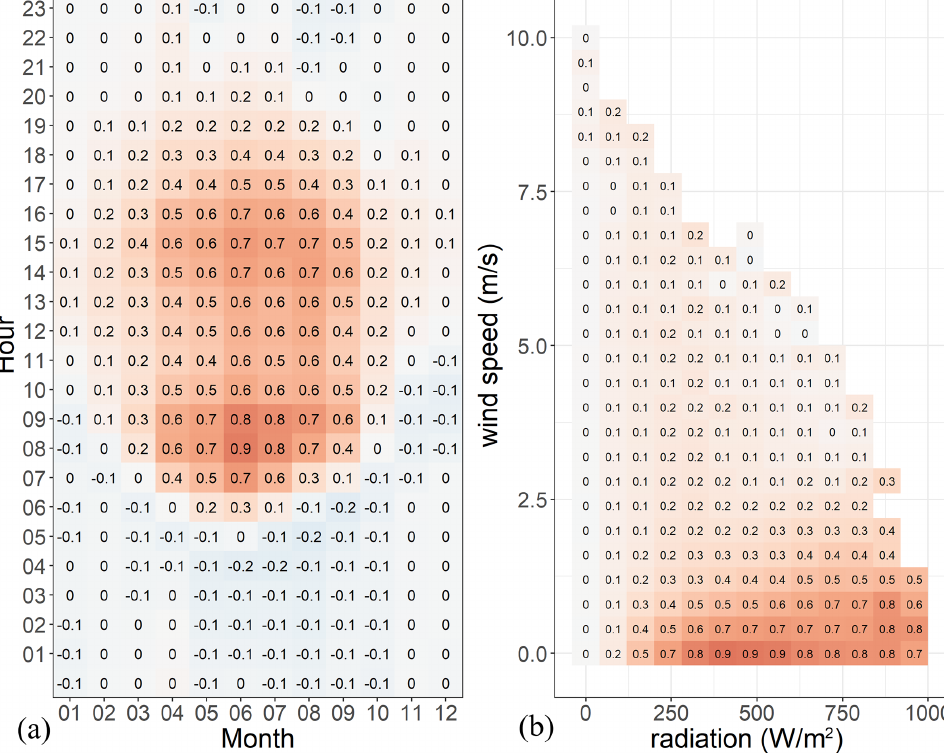
Figure 19. (a) Prediction of the temperature bias ( ◦ C) as a function of hour of the day and month of the year for all LC-X stations and (b) prediction of the temperature bias ( ◦ C) as a function of radiation and wind speed for all LC-X stations, although cells with a sample size lower than 10 are not shown in the latter graph. Background colours, ranging from blue ( − 1.7 ◦ C) to red (1.7 ◦ C), represent the temperature bias. The prediction of the temperature bias was calculated for all LC-X measurements from July 2019 to December